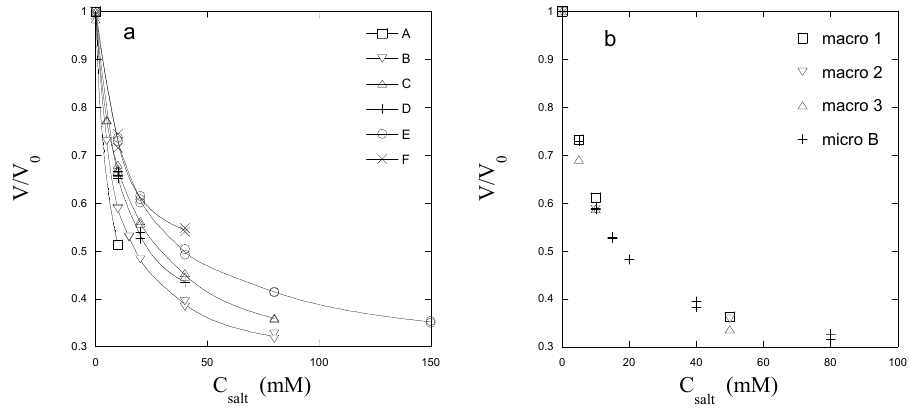
Figure 1. Gel volume (V) relative to that in pure water (V 0 ) plotted vs. the concentration of NaCl in the solution ( C salt ). ( a ) Microgel A–F; ( b ) Microgel B (micro B) and three different macrogels from the same batch (macro 1–3). Gels 2018 , 4 , 9